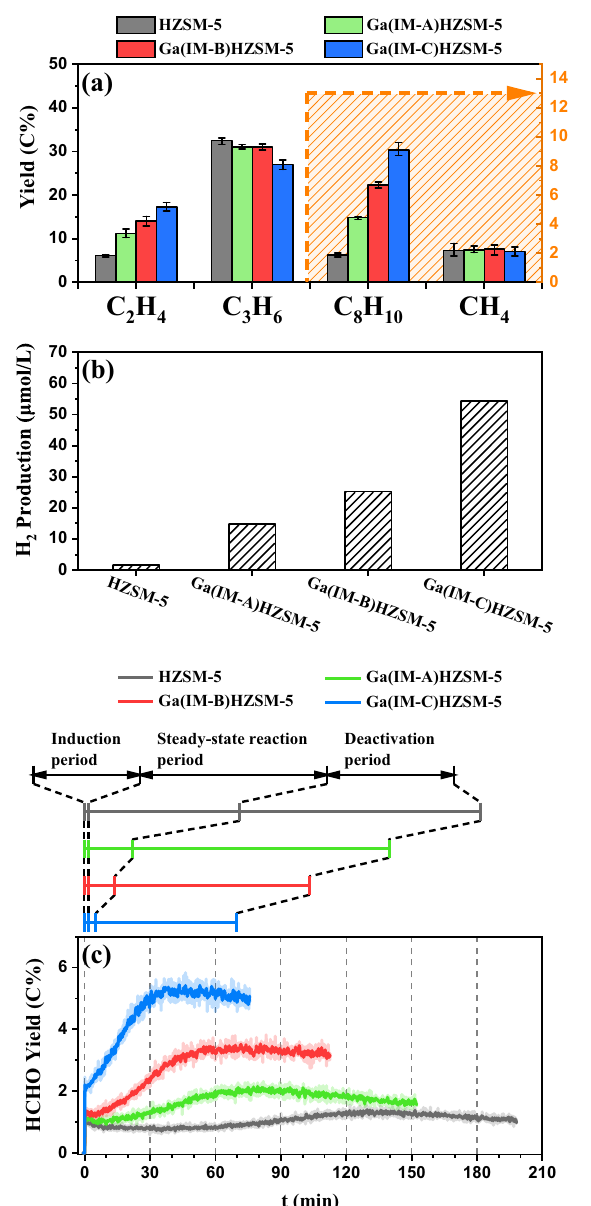
Fig. 2 Product comparation over various Ga contents. a Yields of C 2 H 4 , C 3 H 6 , C 8 H 10 , CH 4 , ( b ) H 2 production and ( c ) the real-time yields (C%) of HCHO in MTH reaction over parent HZSM-5 and various Ga(IM)HZSM-5. Reaction conditions of SR-PIMS experiments: 400 °C; MeOH WHSV = 12.52 g MeOH g catalyst − 1 h − 1 ; and P = 2Torr. C 3 H 6 = propylene; and C 8 H 10 = C 8 aromatics. The yields in ( a ) were obtained during the steady-state reaction period. The H 2 production of the catalyst samples in ( b ) was obtained under atmospheric pressure, which was carried out by GC ‒ MS. Each reaction in ( c ) proceeded until the C 2 H 4 yield dropped to 0.5C%. In ( c ), the original yield curves (transparent solid lines) have been smoothed as bright solid lines. Error bars obtained from repeated three sets of experiments on the same